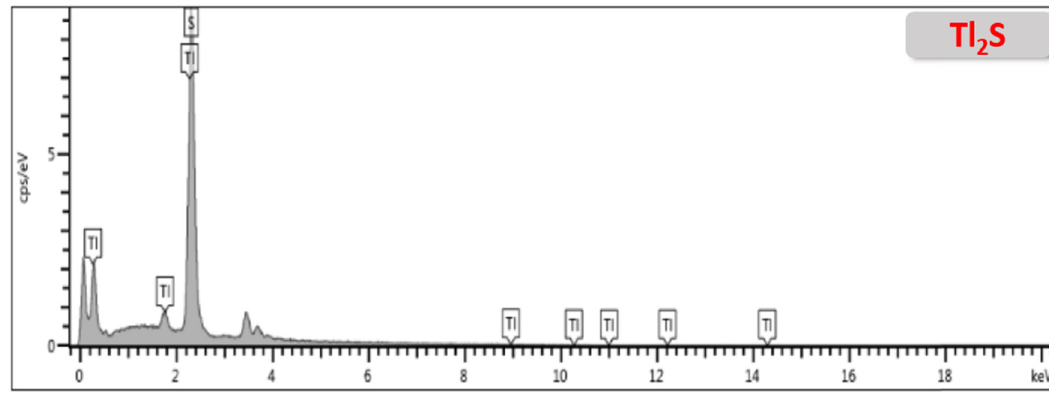
Figure A6: EDX spectra of Tl 2 S thin fi lms fabricated at 600°C con fi rms the presence of Tl and